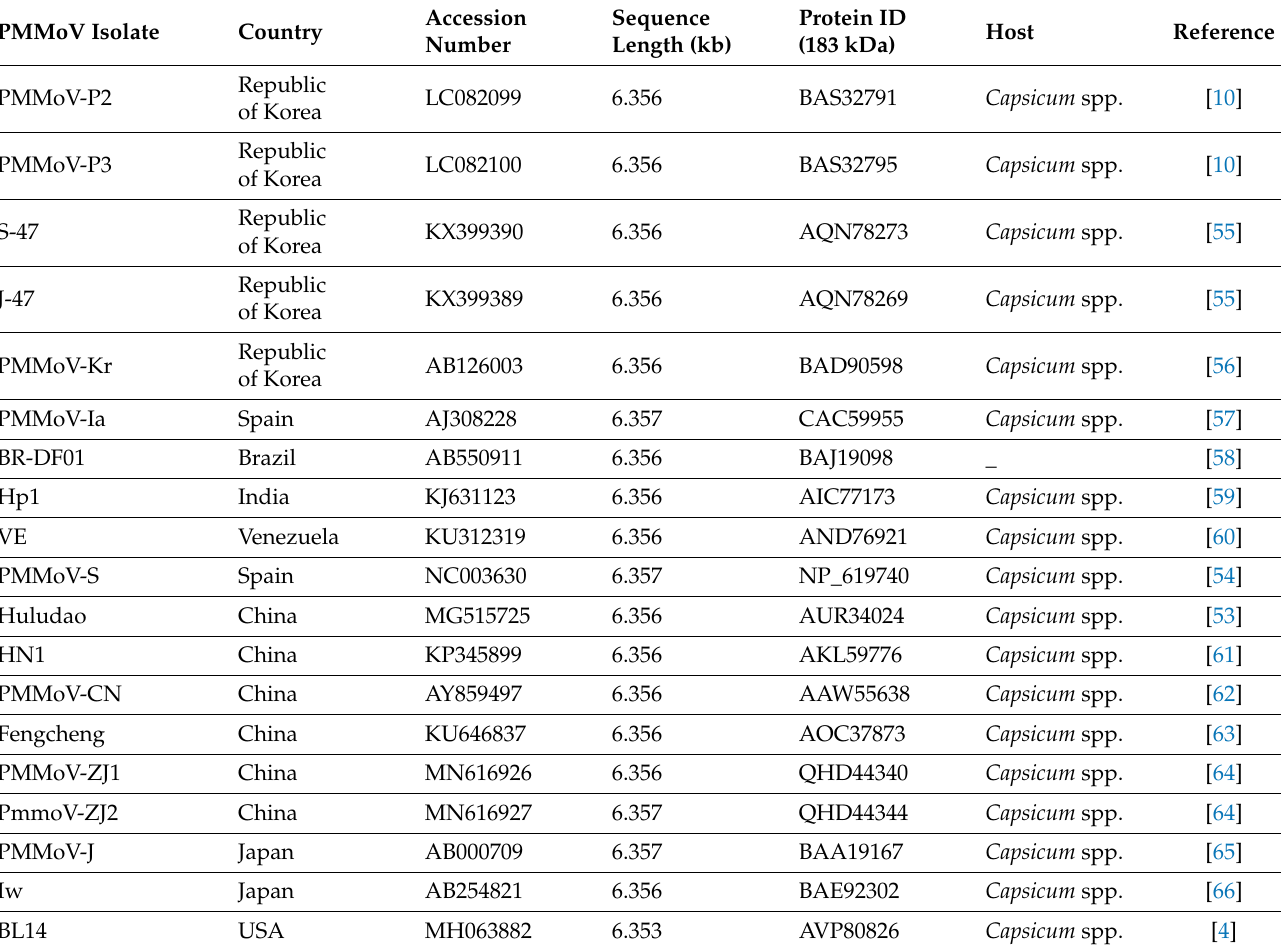
Table 2. PMMoV isolates with available complete genome sequence